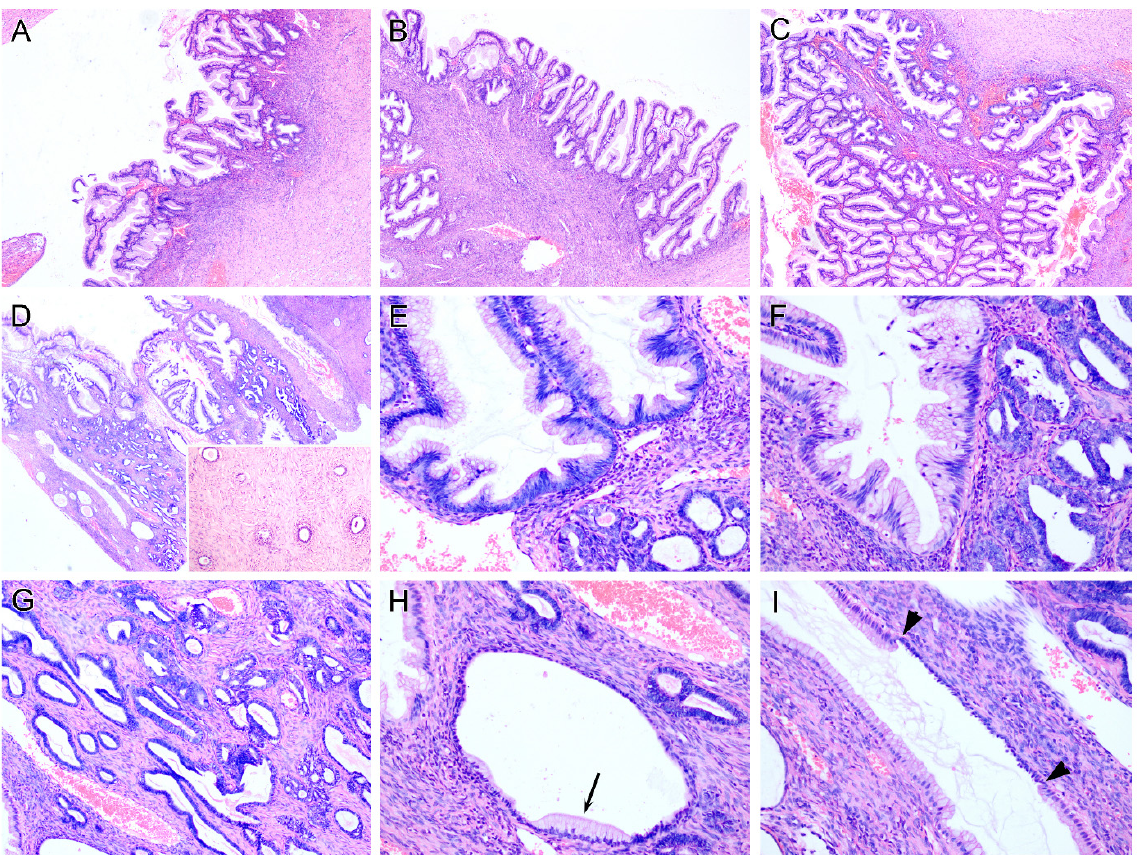
Figure 1. Ovarian mucinous borderline tumor/atypical proliferative mucinous tumor (MBT/APMT) associated with mesonephric-like hyperplasia. The vast majority of the ovarian tumor was composed of MBT/APMT ( A – C ). In one focal area (less than 1% of the total tumor volume), clusters of an atypical glandular proliferation were found adjacent to, or intimately admixed with, the mucinous glands ( D – F ). Some of the proliferative tubules displayed glandular enlargement, crowding, irregular shape and pseudo-stratification, indicating a hyperplastic process ( G ). On high power, some mesonephric-like glands partially exhibited gastrointestinal-type mucinous metaplasia/differentiation ( H ), arrow indicates metaplastic mucinous epithelium; ( I ), arrow head indicates the junction between cuboidal mesonephric epithelium and columnar mucinous epithelium). In some areas away from the focus of hyperplasia, individual benign mesonephric/mesonephric-like glands, lacking hyperplastic features, were present, which were not associated with the mucinous-type epithelium ( D , inset).